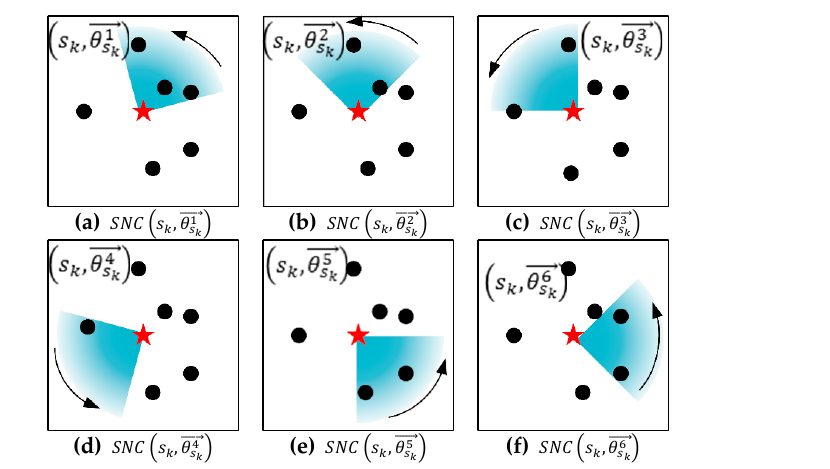
Figure 7. An example for showing the procedure of DMCU (Direction and Maximum Coverage Utility) algorithm.